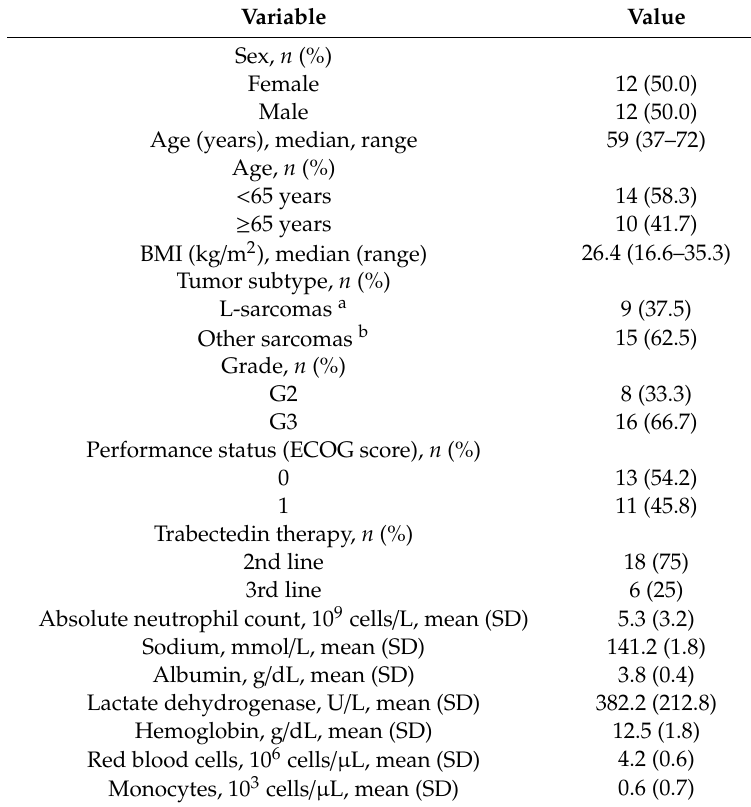
Table 1. Clinical characteristics of 24 patients with metastatic soft tissue